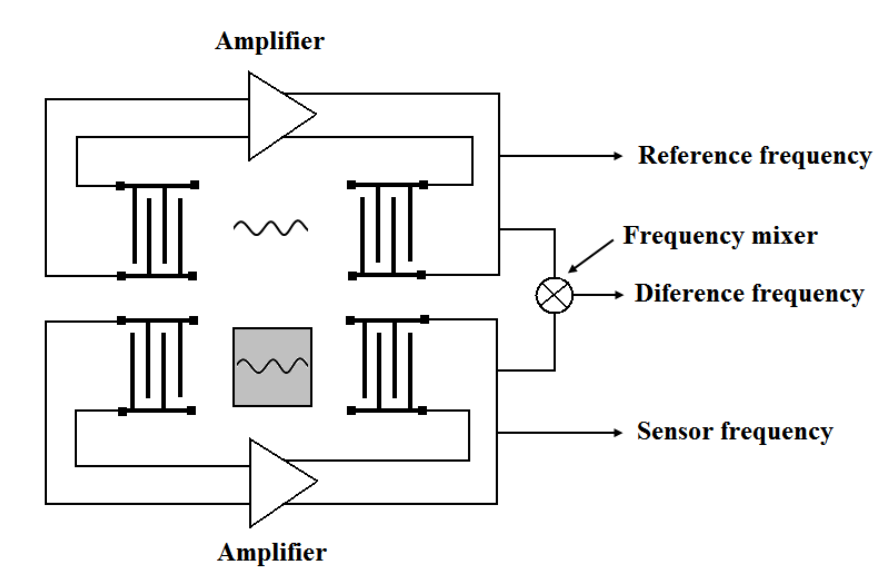
Figure 7. Dual-channel delay line configuration